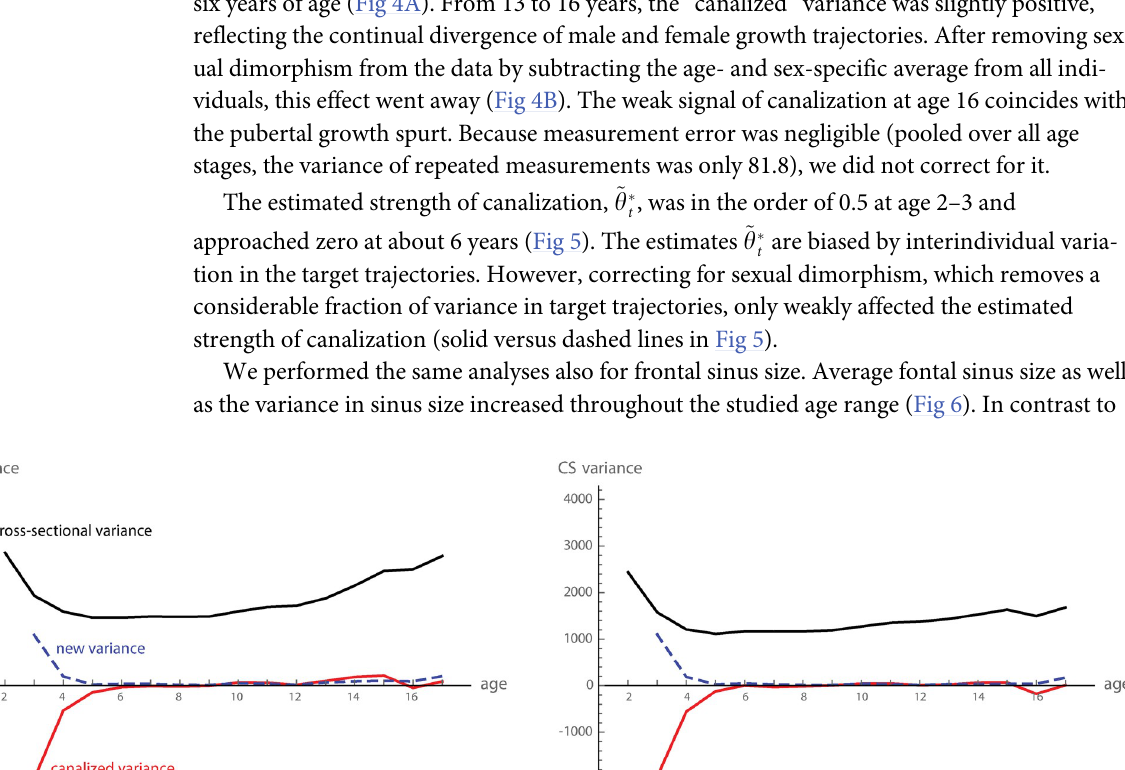
PLOS Computational Biology | https://doi.org/10.1371/journal.pcbi.1008381 February16,